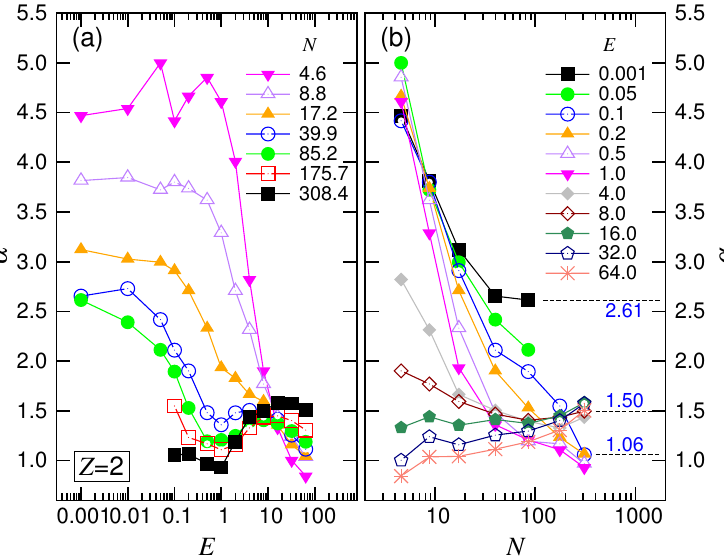
Figure 11. Exponent α ( a ) as a function of E at different N and ( b ) as a function of N for different E , in the divalent salt solution. The values of N in the plots are the geometric means of the adjacent N pairs in the legend of Figure